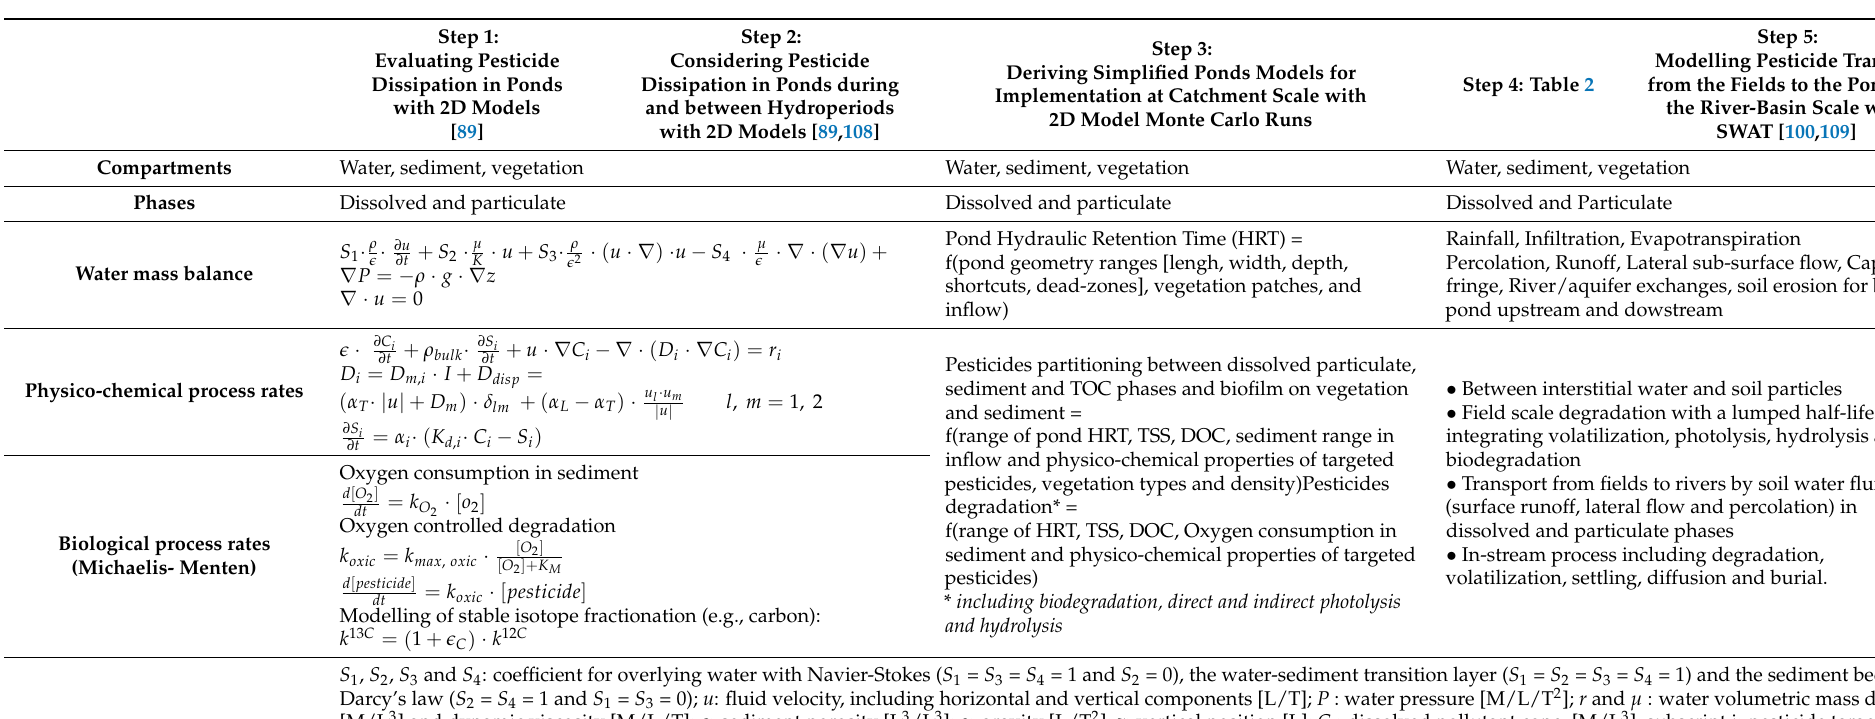
Table 1. Compartments, phases and reactive transport equations associated with the steps 1, 2, 3 and 5 of the integrated modelling framework. The step 4 of the modelling framework is detailed in the Table